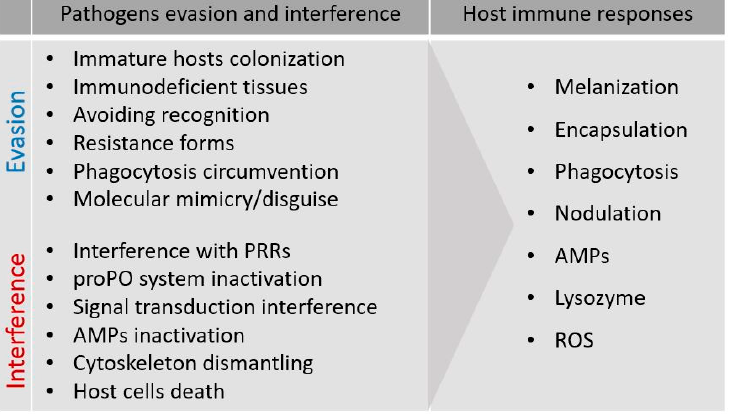
Figure 2. Summary of pathogens immune evasion/interference strategies and host immune responses.